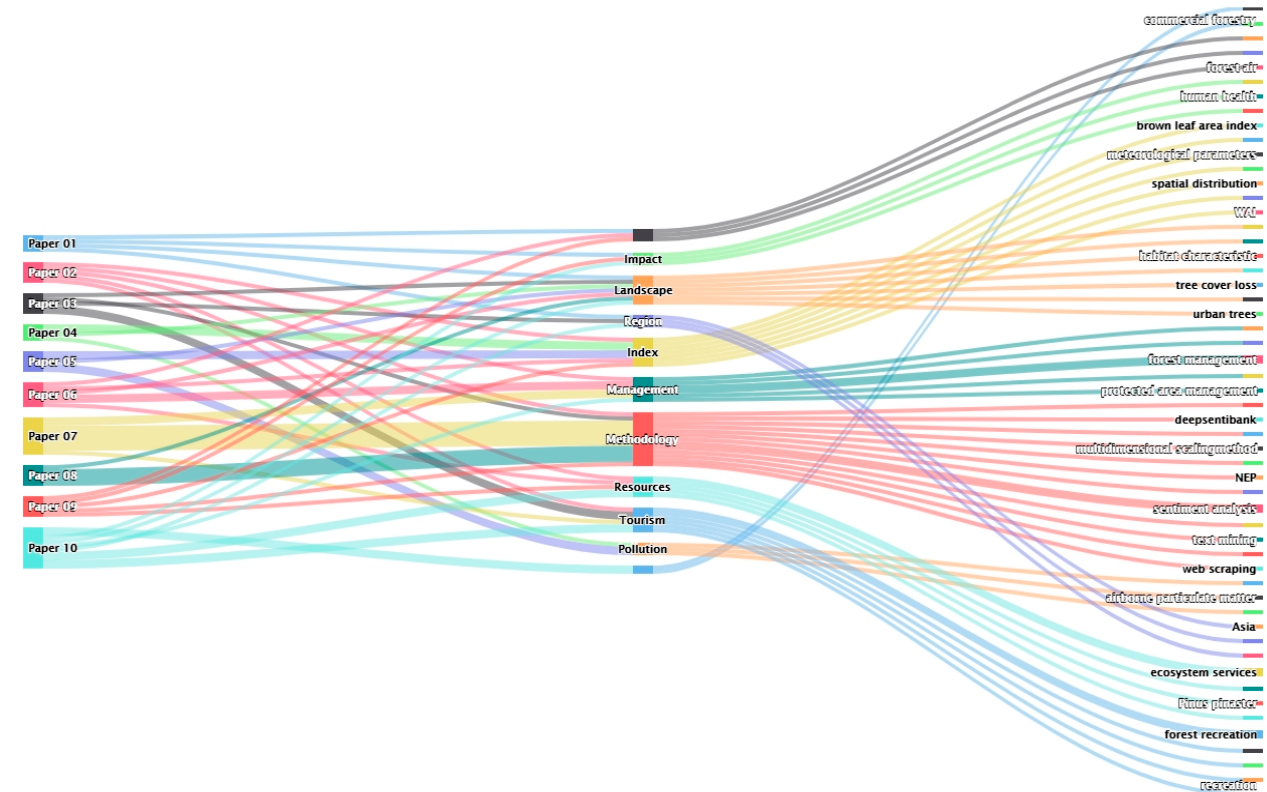
Figure 4. Papers in the Special Issue/family of keywords/keywords. Data source: [1–10].